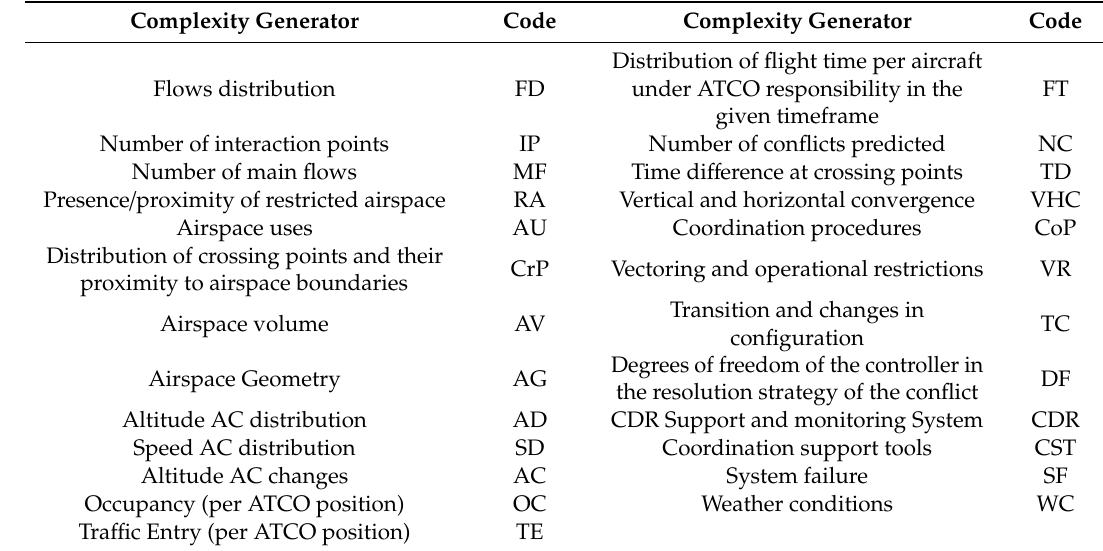
Table 6. Codes for Complexity